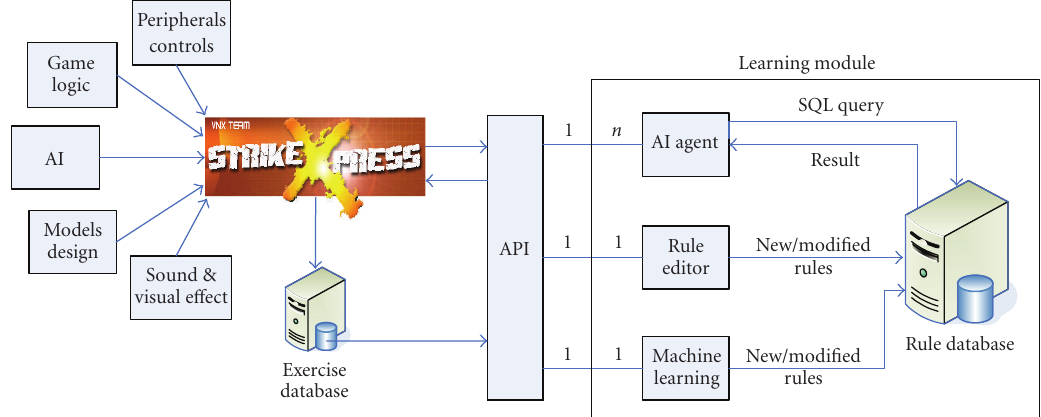
Figure 3: The overall project architecture.